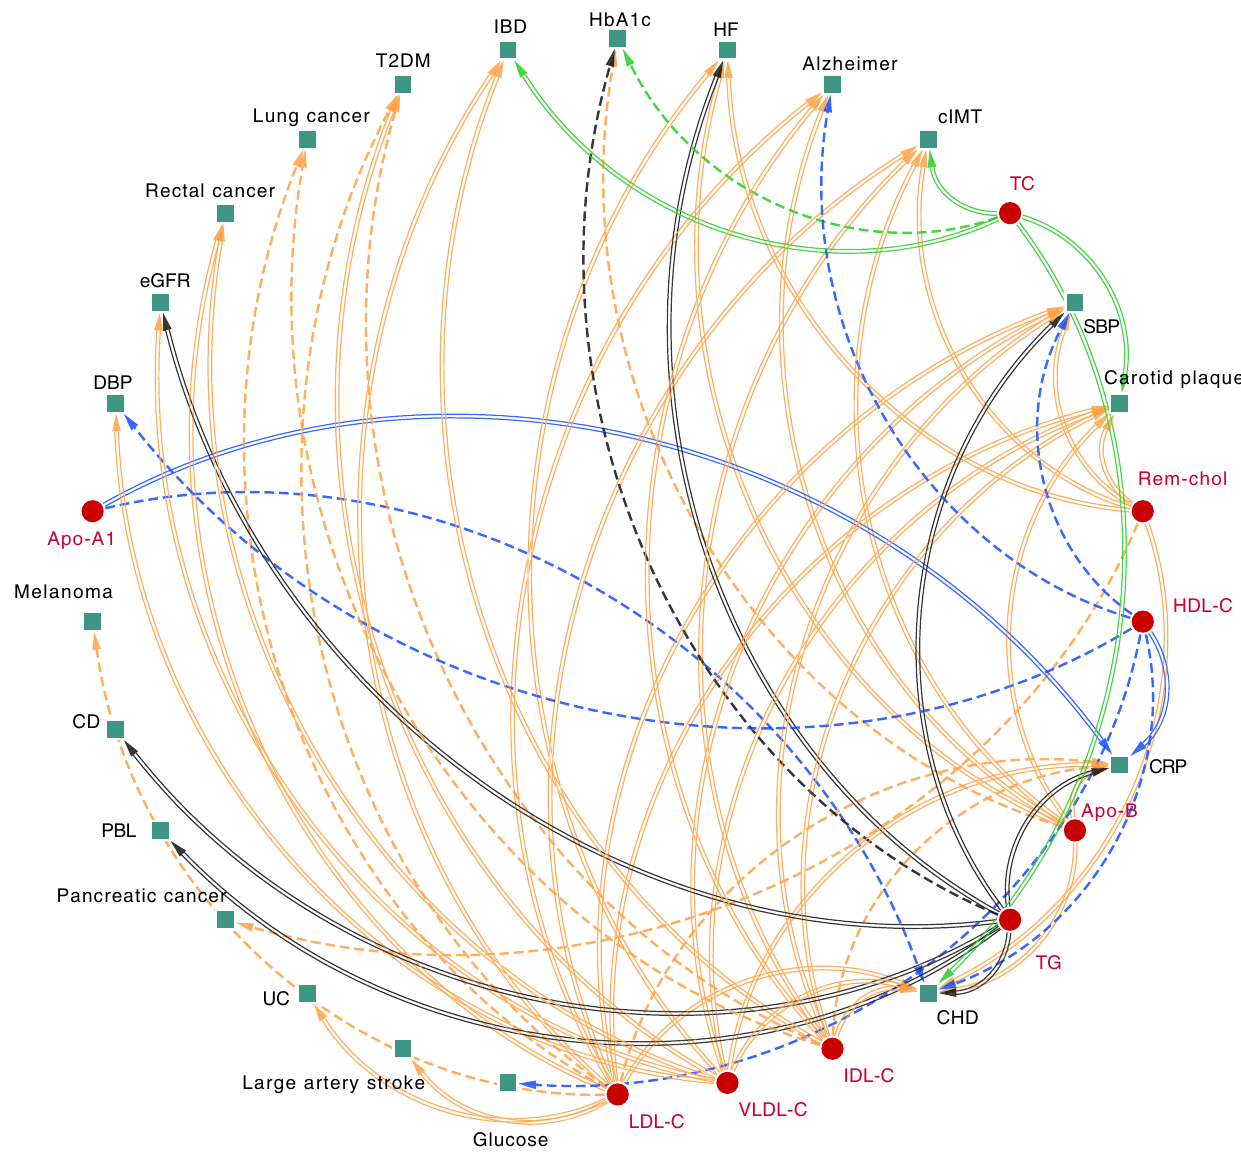
Fig. 3 A causal network of phenotypic consequences of higher cholesterol-containing lipoprotein and apolipoprotein blood concentration. The network represents highly supported pathways that likely act independently of LDL-C, HDL-C and TG (which are included as reference). Arcs belonging to the endogenous pathway (VLDL-C, IDL-C, LDL-C, and Apo-B) were coloured yellow , arcs for HDL-C and Apo-A1, belonging to the reverse cholesterol transport pathway were depicted in blue , TC and TG arcs were represented as black and green, respectively. An increasing effect of a higher exposure concentration was mapped to a double lined arc, a decreasing effect to a dashed arc. An arc was included when the MR effects were signi fi cant at an alpha of 0.05 and showed directionally concordant results in at least three of out fi ve potential models (four for LDL-C, HDL-C, and TG): I) total effects, the direct effects conditional II) on LDL-C, III) on HDL-C, IV) on TG, and V) all three blood lipids; see “ Methods ” . Please see the Fig. 2 for a de fi nition of the